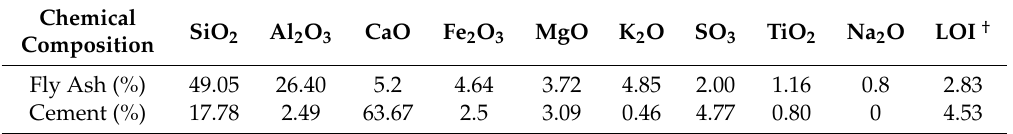
Table 2. The mineral compositions of cement.